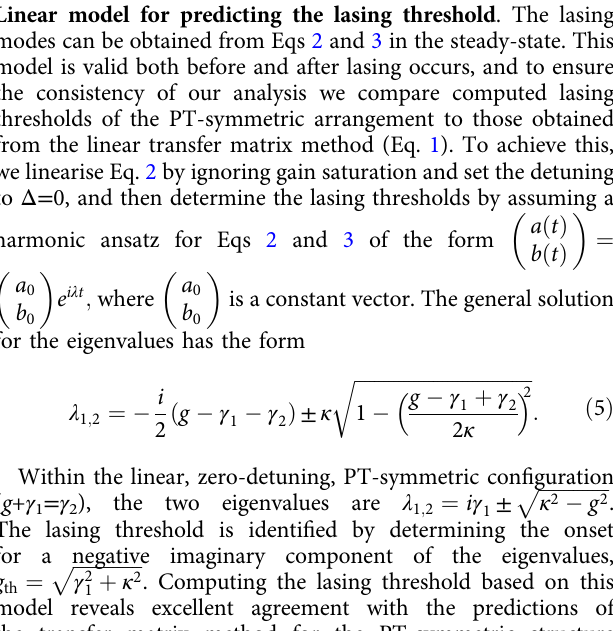
Fig. 3 Resonance detuning and its effect on eigenvalue bifurcation. a , In the absence of detuning, the resonance frequencies of the gain (red) and lossy (blue) sub-cavities are aligned. b , In the presence of detuning Δ ( (cid:3) ω FSR = 2 < Δ < ω FSR = 2), the sub-cavity resonances are no longer aligned. c , d , Candidates for the probability distribution P ( Δ ) of the detuning: ( c ) a Gaussian or ( d ) a uniform distribution. e , f , Trajectories of e the real and f imaginary components of the eigenvalues λ 1,2 for a linear PT-symmetric con fi guration g + γ 1 = γ 2 . Dashed curves correspond to Δ = 0, whereas the solid curves are for the case Δ ¼ ω FSR = 10. The shaded regions correspond to all the intermediate detuning values. As the gain g increases, the real parts of the eigenvalues Re{ λ } tend to coalesce whereas the corresponding imaginary parts Im{ λ } bifurcate. The exceptional point at zero-detuning (yellow triangle) occurs at g = κ , whereupon Re{ λ } = 0 and Im{ λ } = γ 1 , thus separating the unbroken (U) and broken (B) PT-symmetric phases. The green circle corresponds to the experimental value for the lasing threshold at R 2 = 6.8% (Table 1), plotted on the axis to represent gain-clamping. Inset in e shows the PT-cavity con fi guration. g , The domains of operation of a structured cavity as dictated by the values of gain g and loss γ 2 ( γ 2 = 0). The dotted line g = γ 2 corresponds to the PT-symmetric condition. The dashed line g + γ 2 = 2 κ separates the unbroken (U, g < 2 κ − γ 2 , represented by circles) and broken (B, g > 2 κ − γ 2 , represented by edges) domains, according to Eq. (5). The lasing (red) and non-lasing (blue) regions are delineated by a solid line (the lasing threshold). In U, lasing occurs when g > γ 2 , whereas lasing occurs in B when g > κ 2 / γ